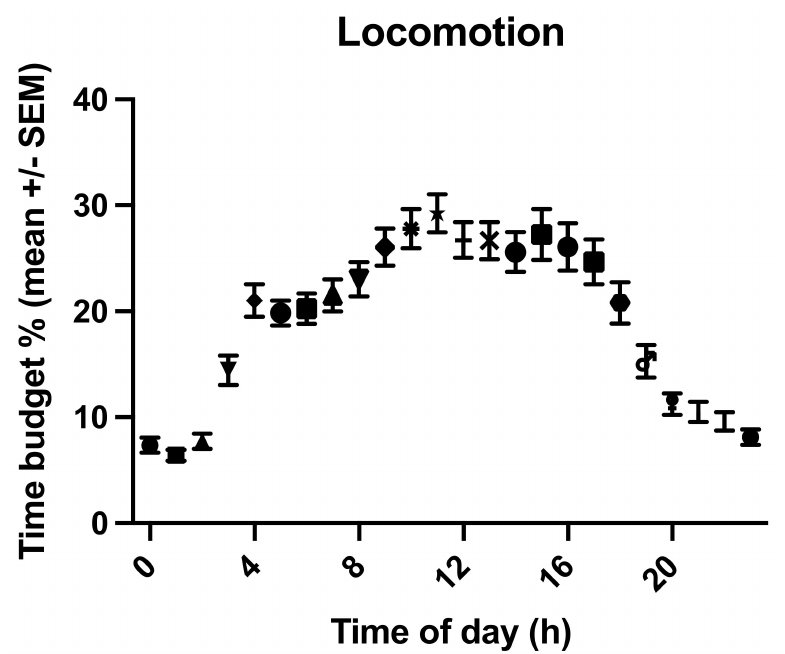
Figure 7. Graph of the locomotion time budget (mean % of 24 h +/ − SEM) throughout the day, showing the movement peak during daytime hours and less movement at night.